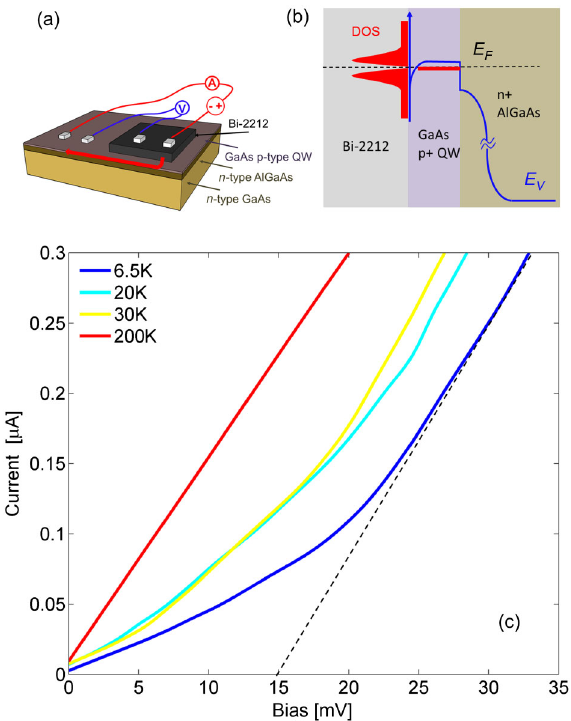
FIG. 3. (a) Schematic drawing of the Bi-2212/GaAs/AlGaAs device. (b) Energy diagram of the device. (c) Measured DC I-V characteristics for the Bi-2212/GaAs/AlGaAs junction at various temperatures. The dashed line indicates a linear I-V dependence coinciding with the 6.5-K measurement at a higher bias to indicate the excess